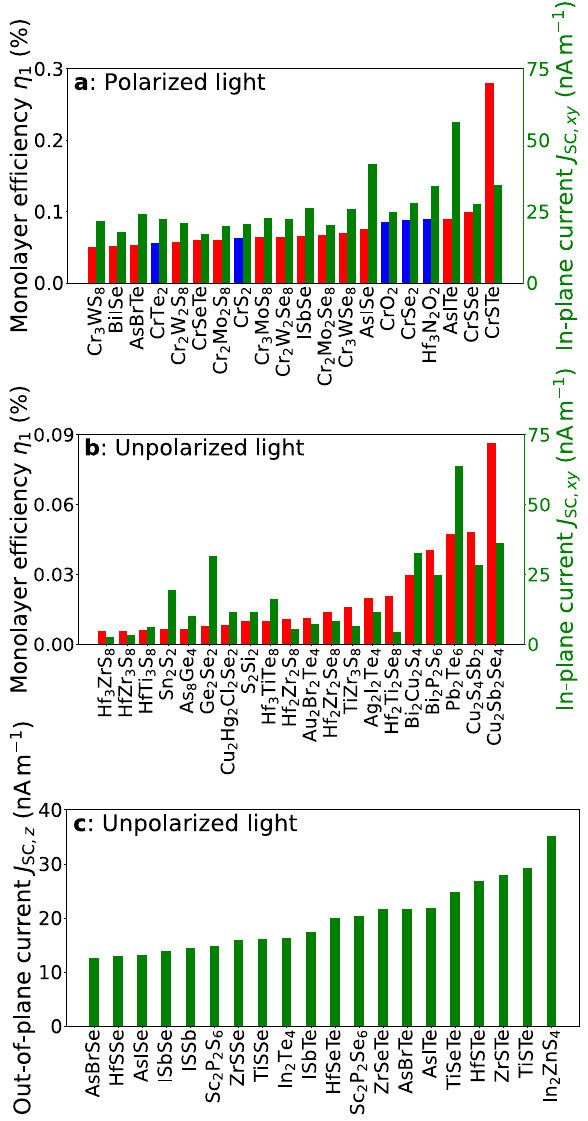
Fig. 2 Monolayer PV ef fi ciencies with impurity-limited mobilities. a , b Monolayer PV ef fi ciencies and in-plane SCs (green bars) of the twenty most ef fi cient 2D materials, as calculated from Eq. (10), using parameters from C2DB and a standard solar spectrum, with a and without b polarization fi lter, respectively. The color of the bars in a indicate polar (red) and non-polar (blue) compounds. c Out-of- plane SC magnitude for the twenty materials with the highest response under unpolarized light.